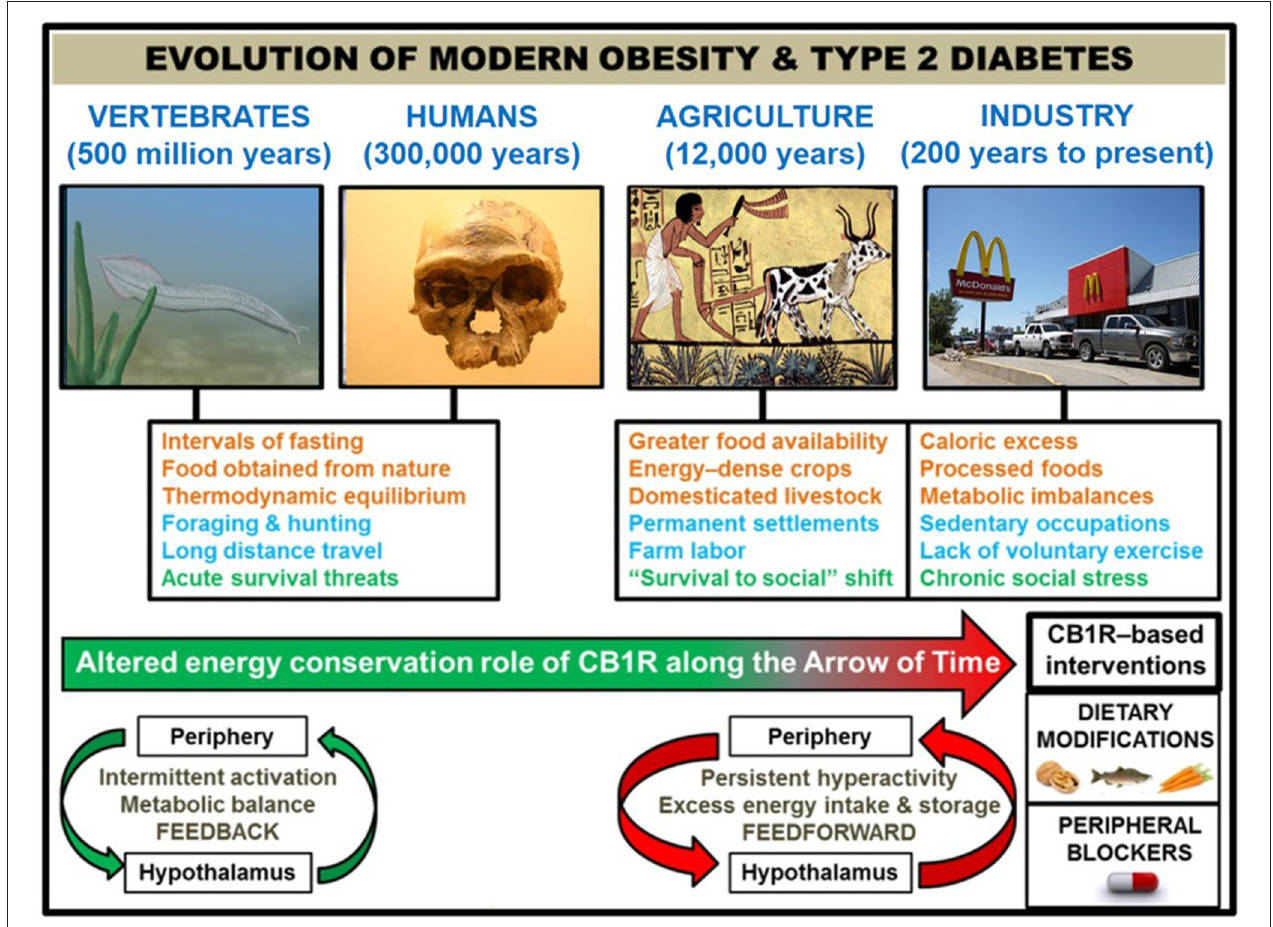
FIGURE 1 | Correlation of human societal transitions with fundamental alteration of eCB/CB1R system’s energy conservation function. Upon their initial appearance in the fossil record circa 300,000 years ago ( 22), anatomically-modern Homo sapiens existed in primitive hunter-gatherer societies characterized by nomadism and obtaining nourishment directly from nature. This lifestyle was likely characterized by repeated bouts of strenuous physical activity, dietary patterns which properly regulated weight at the metabolic set point, and acute stressful situations such as natural predators or extreme cold weather. The Agricultural Revolution (beginning ∼ 12,000 years ago) eliminated many unpredictable aspects of this lifestyle that, although subject to individual variations between species, were largely preserved across 500 million years of vertebrate evolution that began with primitive chordates such as the pictured Pikaia gracilens . Elaborate social networks and division of labor permitted the widespread abundance of energy-dense foods from animals (e.g., livestock meat and dairy) and plants (e.g., grains and potatoes). Stress became less focused on survival and more on social situations. Although the nomadic lifestyle went largely extinct, the majority of the human population has been engaged in farm labor for much of recorded history [e.g., 90% of population during Medieval Period were rural peasants (23)]. The dominance of agriculture gave way to industrialization and urbanization starting in the 1800s, and this movement has considerably shaped the present-day living conditions within developed countries. Technological advances have dramatically altered diet (shift from natural to processed foods and metabolic imbalances like leptin/insulin resistance, skewed omega 3 to omega 6 ratio, and high glycemic load), exercise (mechanized transport and sedentary occupations removed impetus for voluntary physical activity), and stress (chronic psychosocial/emotional stressors). In order to impede human metabolic disease, it is proposed that interventions centered on the eCB/CB1R system (e.g., omega-3 fatty acid supplementation, consumption of natural product CB1R inhibitors, and a pharmacological CB1R antagonist) represent efficacious strategies grounded in the context of biological evolution. Studies of animal models and humans suggest that hyperactive CB1R signaling, maintained in and among peripheral organs and integrated by the hypothalamus, is a mechanistic culprit behind the astronomical rise in obesity/T2D since the dawn of technologically advanced societies. CB1R signaling would have functioned as an efficient regulator of energy balance and metabolism in an environment of regular physical activity and irregular, low energy density feedings. However, the introduction of a more “cushioned” lifestyle, buffered from the laws of natural selection, rendered the peripheral eCB energy integration system “vestigial” beginning in the Agricultural Revolution. It was not until widespread industrialization that the character of eCB/CB1R signaling across the brain-gut axis became a pathologically overactive feed-forward mechanism, driven by the availability of energy-dense food and lack of regular exercise.